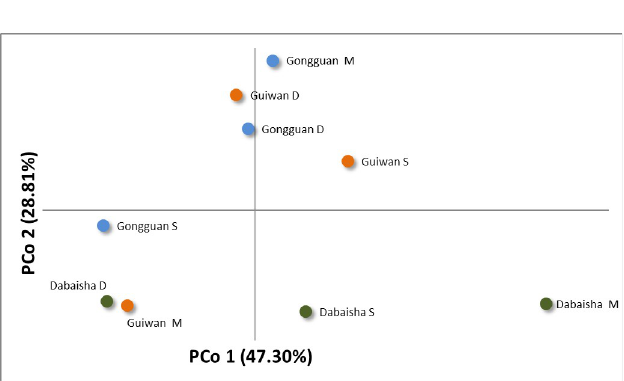
Fig 3. Principal Coordinate Analysis (PCoA) of standardized genotypic distances computed between locations.